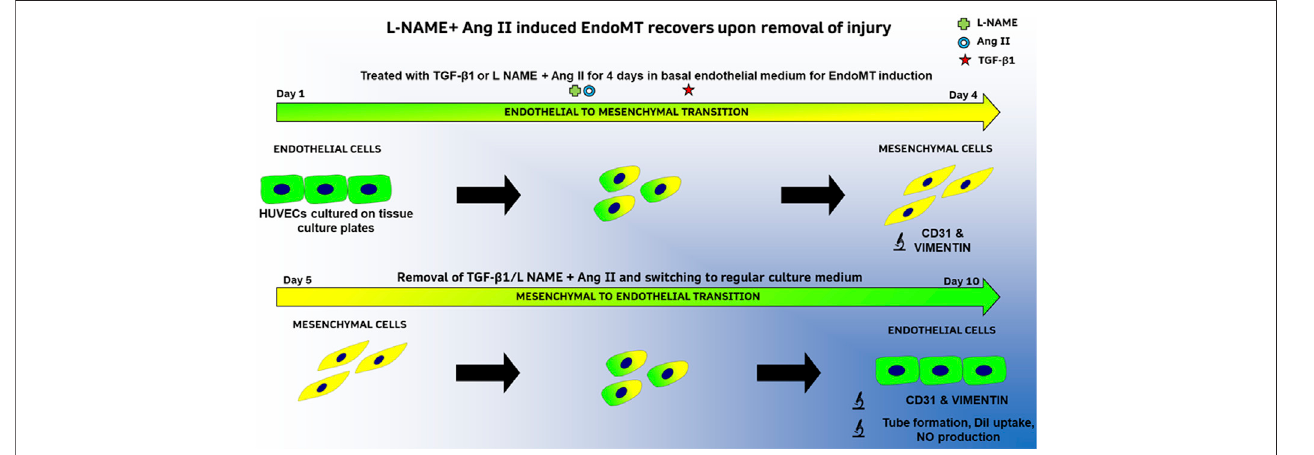
FIGURE 1 | Summary of methods to study EndoMT and its reversal in HUVECs with TGF- β 1 or L-NAME + Ang